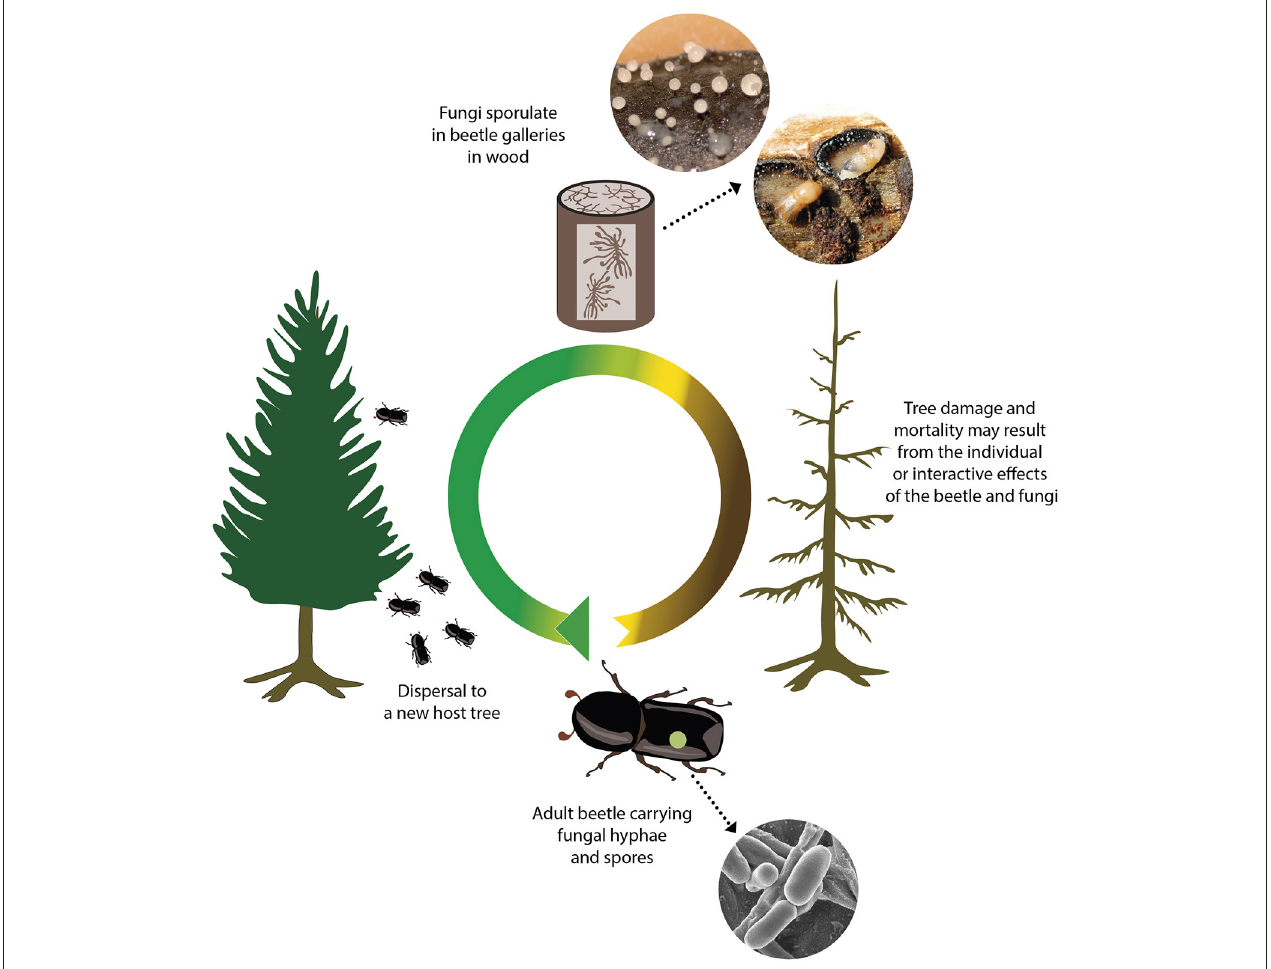
FIGURE 1 | The beetle lifecycle and role in fungi transmission. Tree damage caused by fungi associated with wood-boring insects is inherently linked to the beetle lifecycle. The beetle life cycle begins following hatching from an egg in a maternal gallery (tunnel) under the tree bark. The larvae remains in the tunnels, feeds on the phloem and gnaws tunnels. During this stage, fungi grow and sporulate and can serve as a source of nutrition for beetle larvae. Larvae pupate and develop into adults under the bark, before flying in search of new host trees and transporting fungi with them. Fungal spores carried on their exoskeleton, in specialized structures called mycangia or via other associated organisms, are then inoculated into a new host